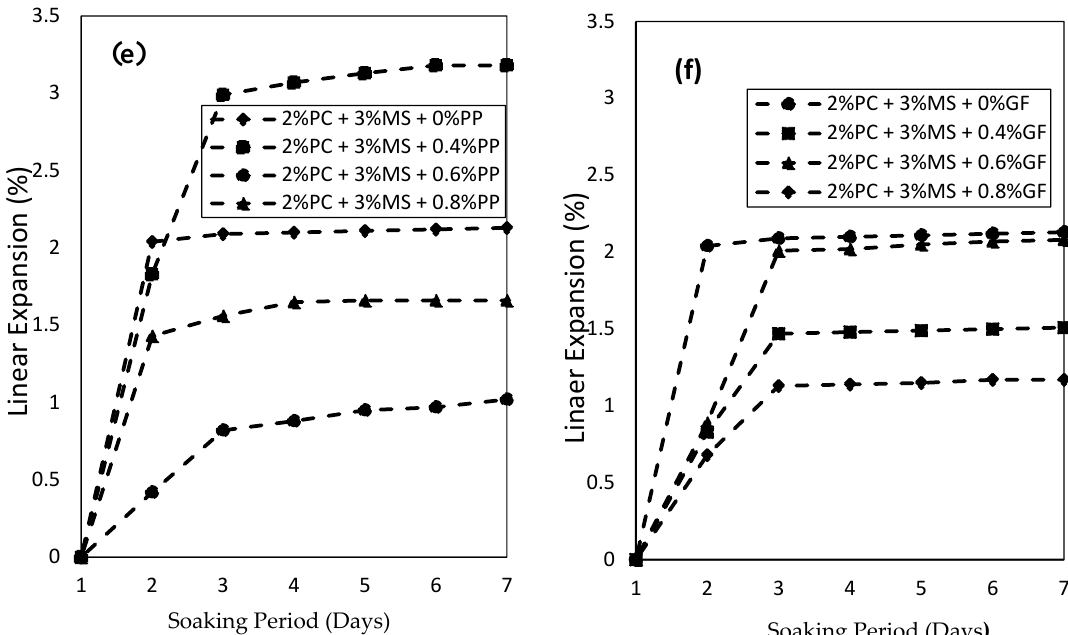
Figure 9. ( a – f ) Linear expansion of the clay-binder mixtures versus soaking time .